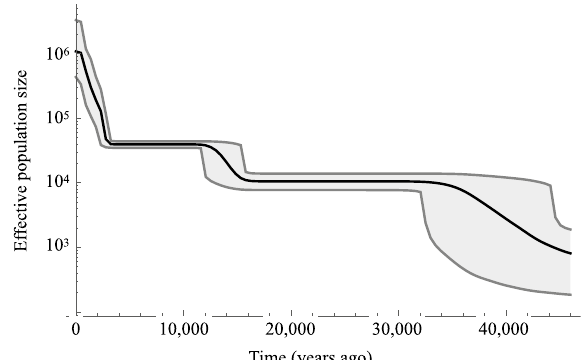
Figure 5. Bayesian Skyline Plot (BSP) of 2,062 present-day Japanese. Effective population size (y axis, log-scale) was plotted against time (x axis, years ago). Solid black line shows the mean effective population size from the posterior distribution. Two grey lines and grey coloured region within them show the 95% posterior density